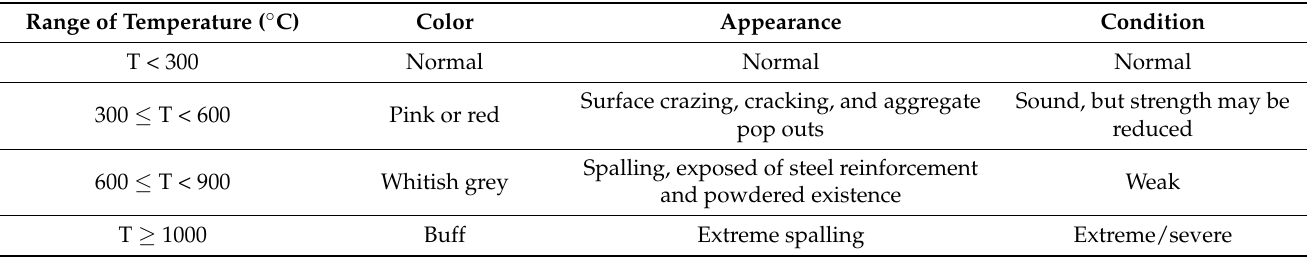
Table 1. Color changes in concrete at specified range of temperature, T.